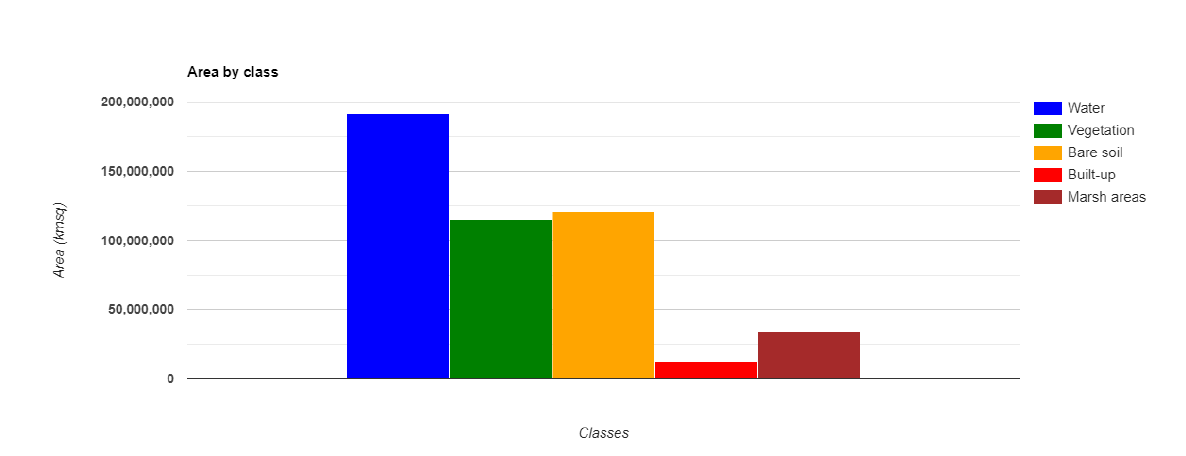
Figure 4 (b) 2021 Random Forest classified